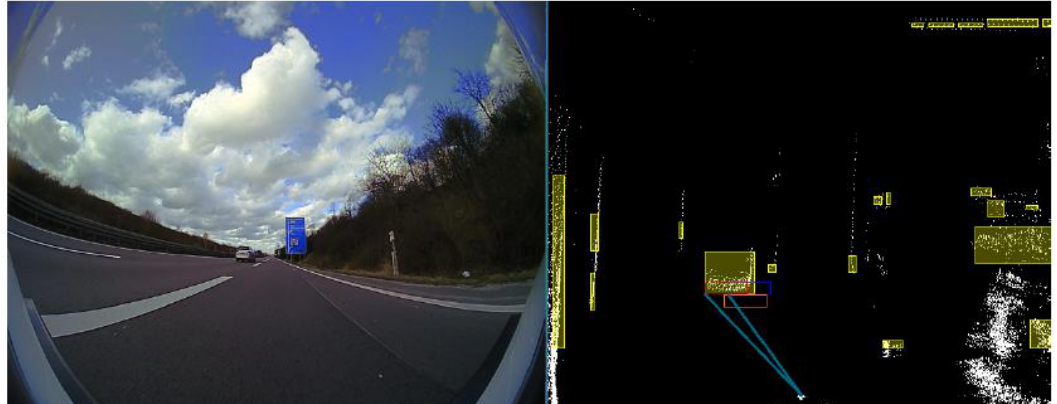
Figure 7. Results of LIDAR object to trifocal object association. On the left-hand side, the color image of the recorded scene is displayed. On the right-hand side, the processed sensory data containing trifocal and LIDAR objects are shown.